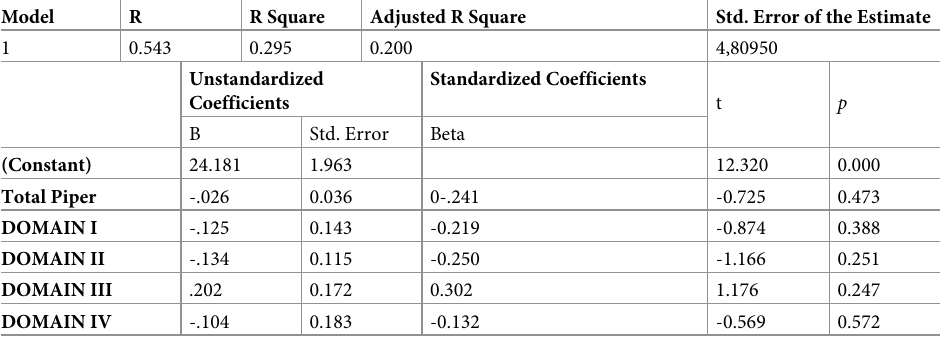
Table 3. Decomposition of the multivariate